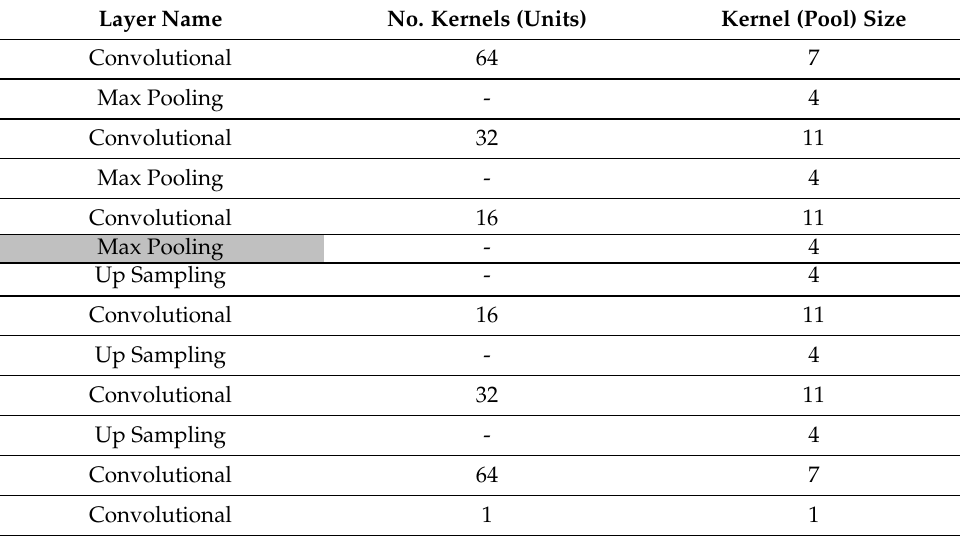
Table 5. CAE architecture with its encoder and decoder